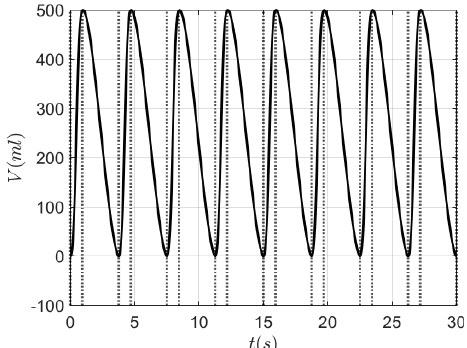
Figure 9. Volume of air insufflated into the patient - case study 2 Again, the numerical results found in the second case study are consistent with what was intuitively expected